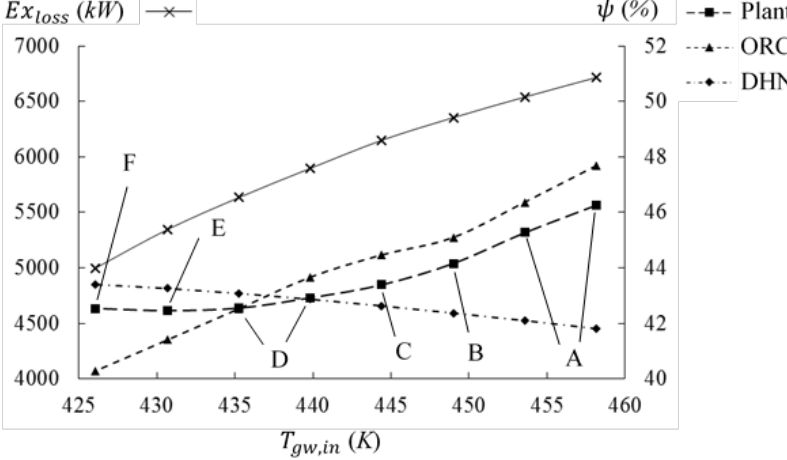
Figure 9. Evolution of 𝐸̇𝑥 𝑙𝑜𝑠𝑠 , 𝜓 𝑂𝑅𝐶 , 𝜓 𝐷𝐻𝑁 , and 𝜓 𝑝𝑙𝑎𝑛𝑡 with the temperature of the geothermal source (letters in 𝜓 𝑝𝑙𝑎𝑛𝑡 curve refer to the DHN configuration in Figure 11).